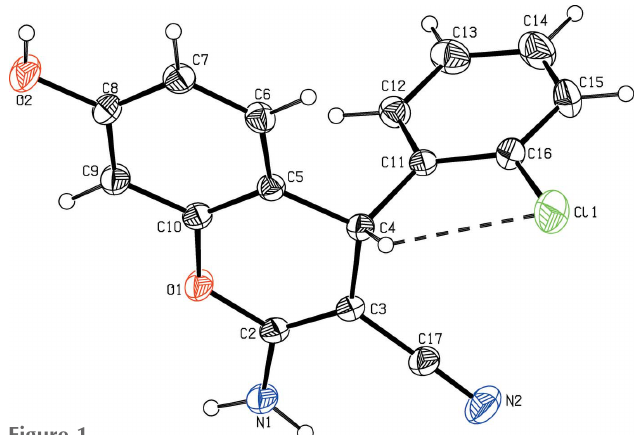
Figure 2 The crystal packing of the title compound, showing an R 2 the C (8) chain formed via a pair of O—H (cid:3)(cid:3)(cid:3) N and N—H (cid:3)(cid:3)(cid:3) O hydrogen